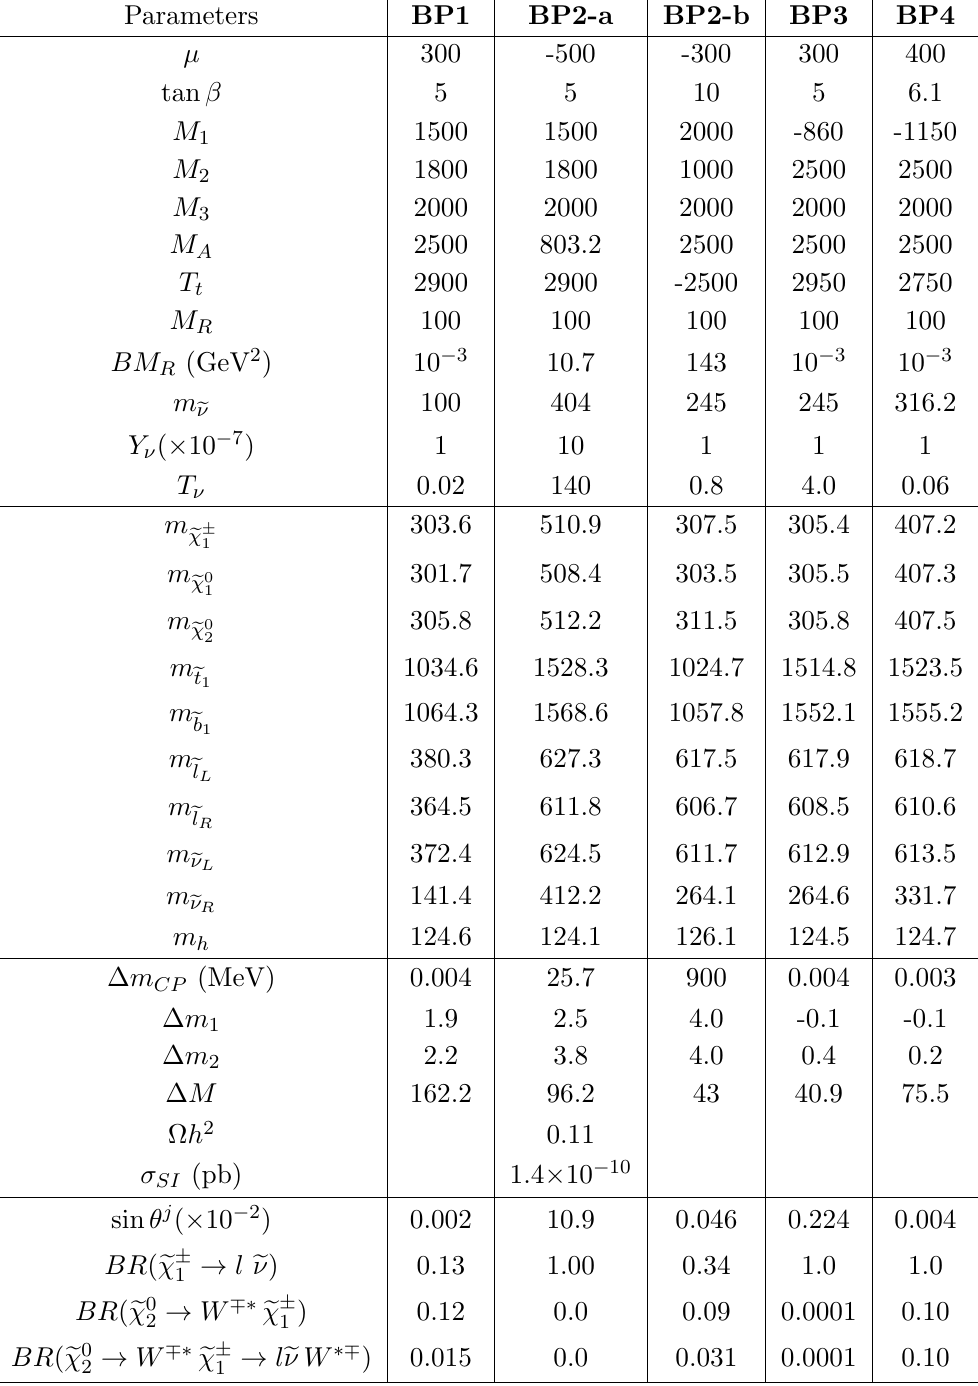
Table 4 . Low energy input parameters and sparticle masses for the benchmarks used in the current study. All soft mass parameters and mass di(cid:11)erences are in GeV. Mass di(cid:11)erences amongst the